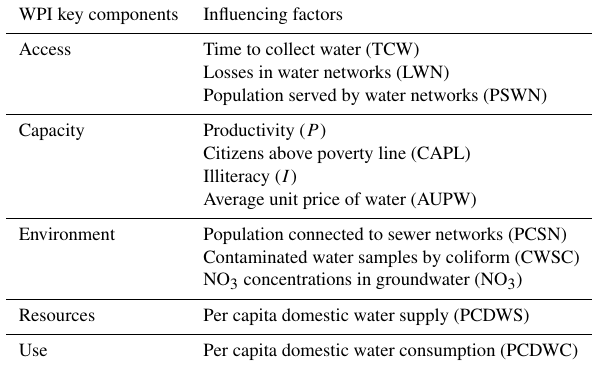
Table 1. Water poverty index (WPI) components and the associated influencing